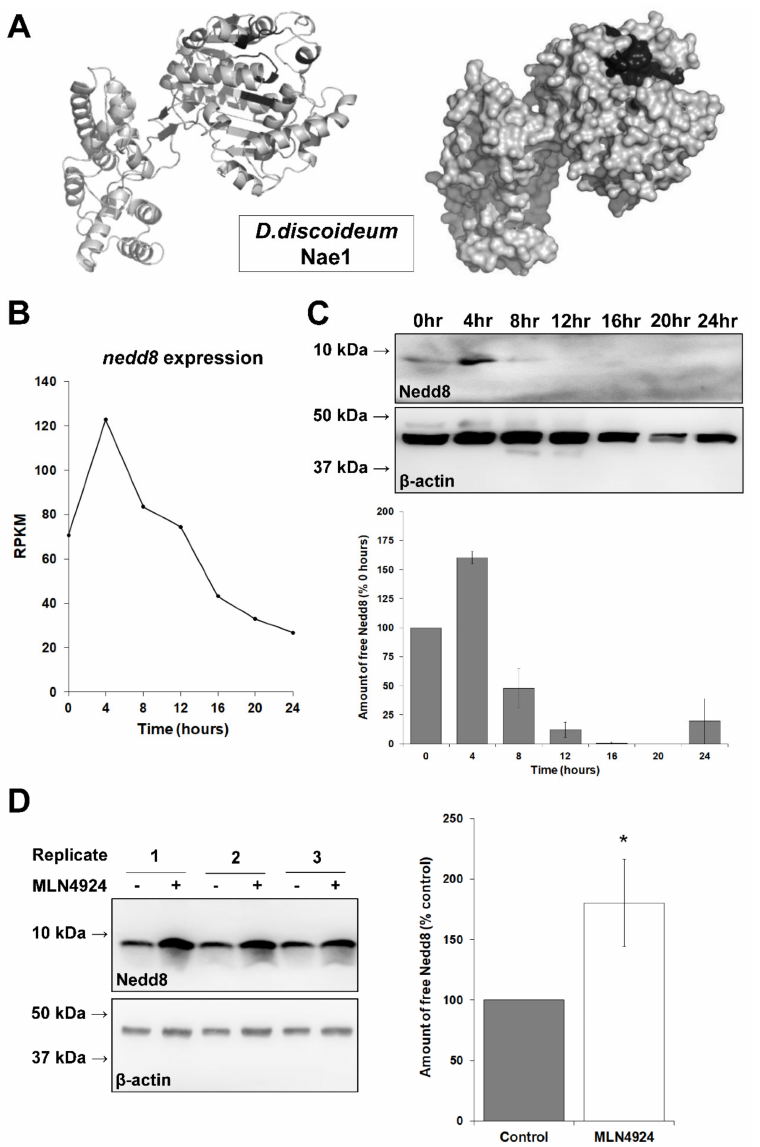
Figure 2. MLN4924 inhibits neddylation in D. discoideum . ( A ) Homology modeling of D. discoideum Nedd8-activating enzyme E1 (Nae1). The structure of Nae1 is highly conserved and predicted to bind MLN4924 (predicted binding pocket indicated in black). ( B ) Expression of nedd8 during D. discoideum growth and multicellular development. The x -axis represents the time of development: 0 h (growth), 4 h (chemotaxis), 8 h (aggregate formation), 12 h (mound), 16 h (slug), 20 h (culminant), 24 h (fruiting body). Reads per kilobase of transcript per million mapped reads (RPKM). RNA-seq data were obtained from dictyExpress and re-plotted using Microsoft Excel. ( C ) Amount of free Nedd8 in cells during the different stages of D. discoideum development. Whole cell lysates (20 µ g total protein) were separated by SDS-PAGE and analyzed by Western blotting with anti-NEDD8 and anti- β -actin (loading control). Western blots are representative of three biological replicates. Molecular weight markers (in kDa) are shown to the left of each blot. Nedd8 protein bands were quantified and standardized against the amount of β -actin. Data are presented as the mean amount of free Nedd8 (% 0 h) ± SEM ( n = 3). ( D ) Effect of MLN4924 on the amount of free Nedd8. Cells were starved in KK2 buffer in the presence and absence of MLN4924 (50 µ M, control: dimethyl sulfoxide) for 6 h, after which time cells were lysed. Whole cell lysates (50 µ g total protein) were separated by SDS-PAGE and analyzed by Western blotting with anti-NEDD8 and anti- β -actin (loading control). Three representative biological replicates are shown. Molecular weight markers (in kDa) are shown to the left of each blot. Nedd8 protein bands were quantified and standardized against the amount of β -actin. Data are presented as the mean amount of free Nedd8 (% control) ± SEM ( n = 19). Statistical significance was assessed using the one-sample t -test. * p < 0.05 vs.